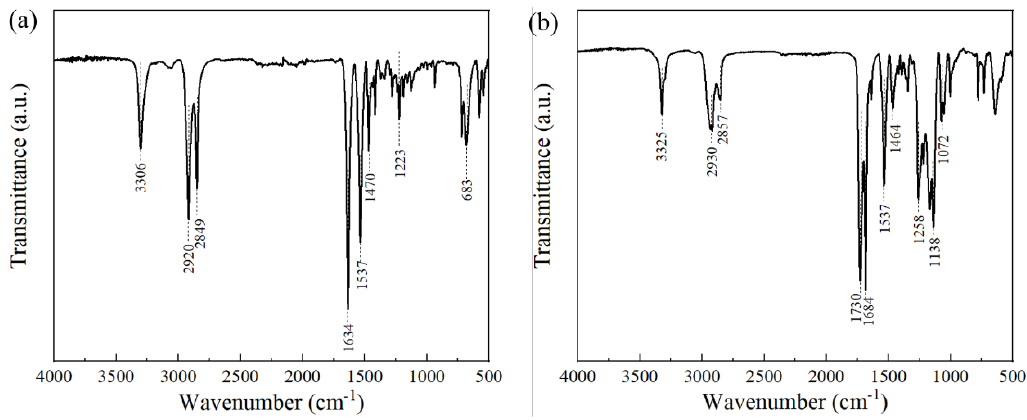
Figure 5. FTIR spectra of powders: ( a ) PA11 and ( b ) TPU.